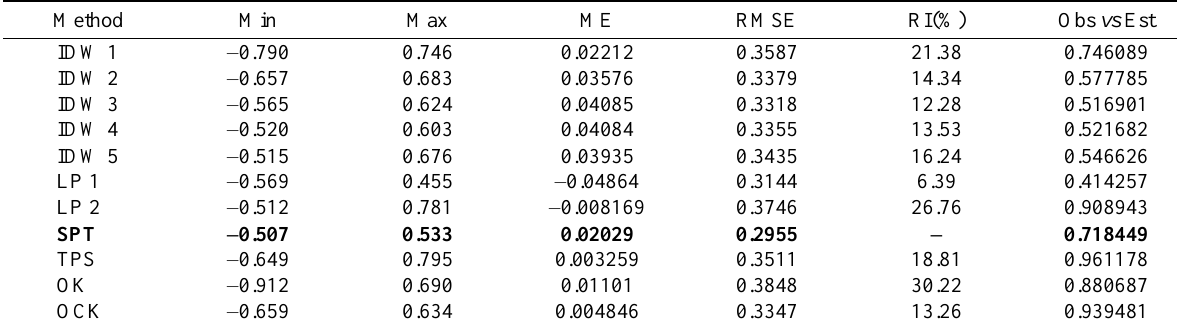
Table 3. Summary statistics of the interpolation methods accuracy. In bold the less biased method